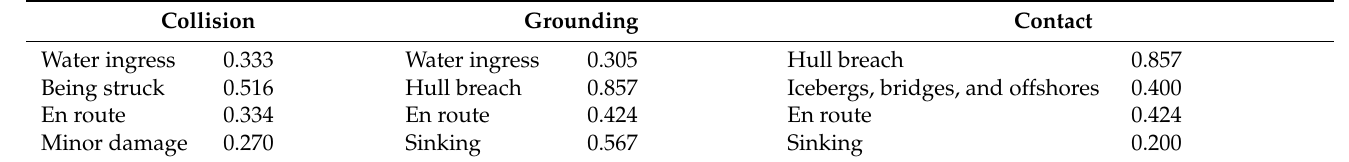
Table 2. Scaling factors as provided by EMSA III [10] and FSA on cruise ships